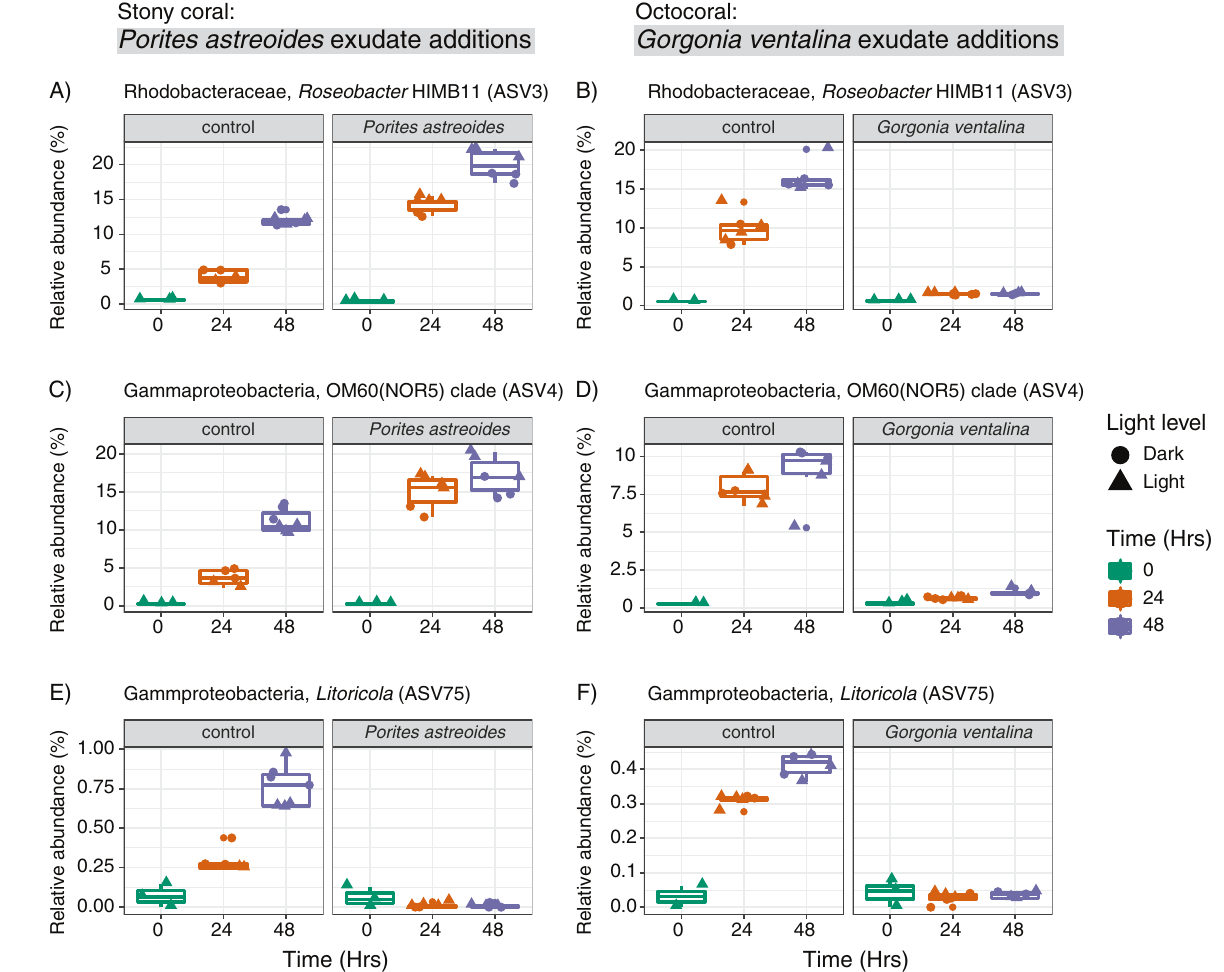
Fig. 5 Relative abundances of speci fi c microbial taxa exhibit similar or different responses to exudates from Porites astreoides and Gorgonia ventalina overtime. Boxplots display relative abundances of ASVs that exhibit different ( A – D ) or similar ( E , F ) trends in response to coral exudates. Plots ( A , C , and E ) show trends in response to P. astreoides exudates and plots ( B , D , and F ) show trends in response to G. ventalina exudates. Symbol color indicates time and shape re fl ects light